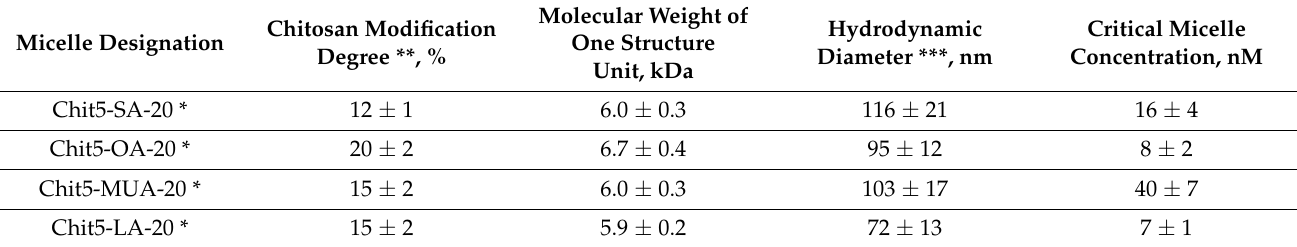
Table 1. Polymeric micelles’ physico-chemical